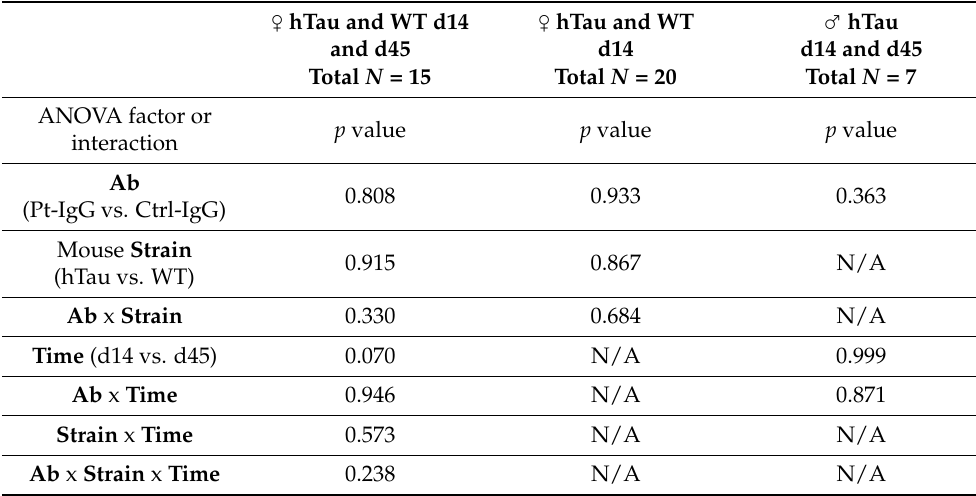
Table A3. Statistical analysis of sleep phenotype: time spent in non-REM sleep.